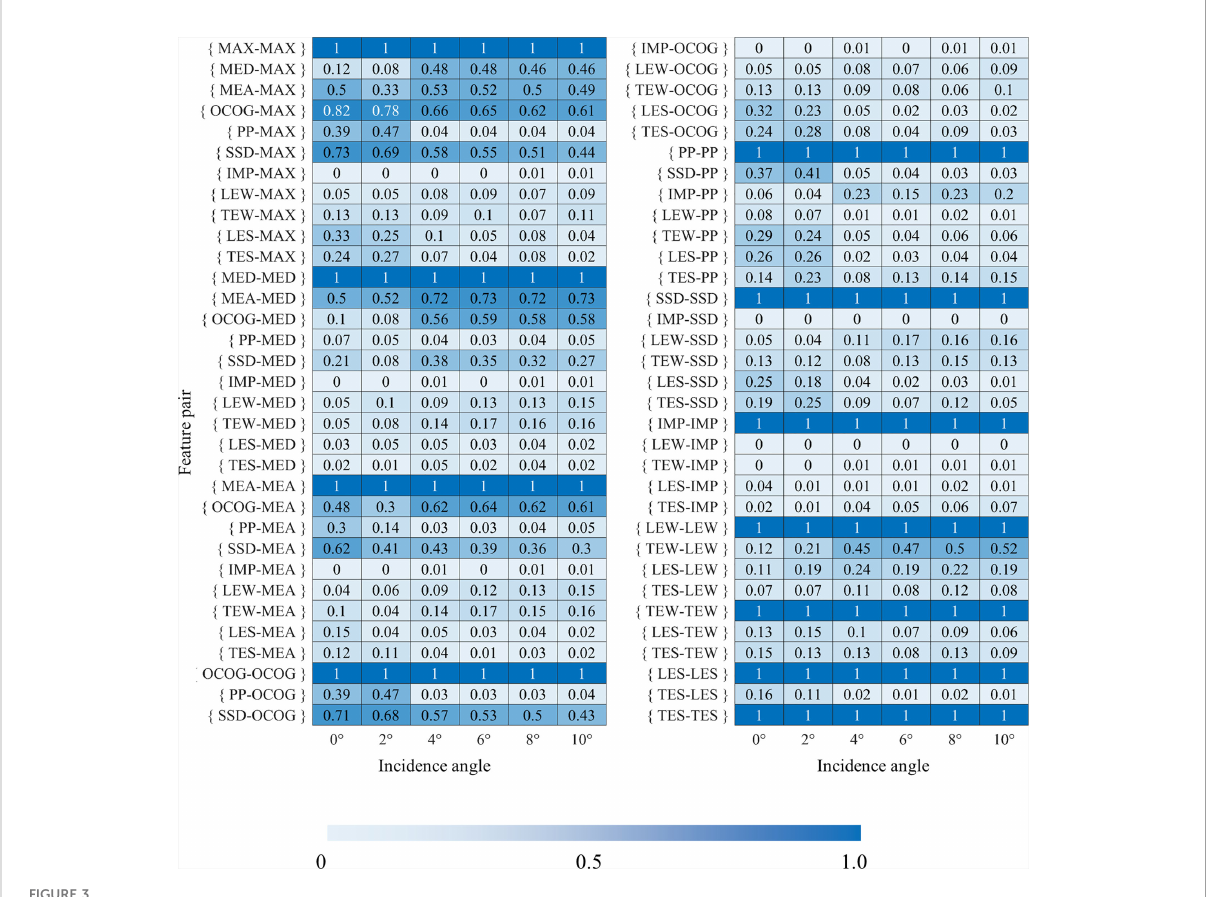
FIGURE 3 MIMs of 66 feature pairs at small incidence angles.